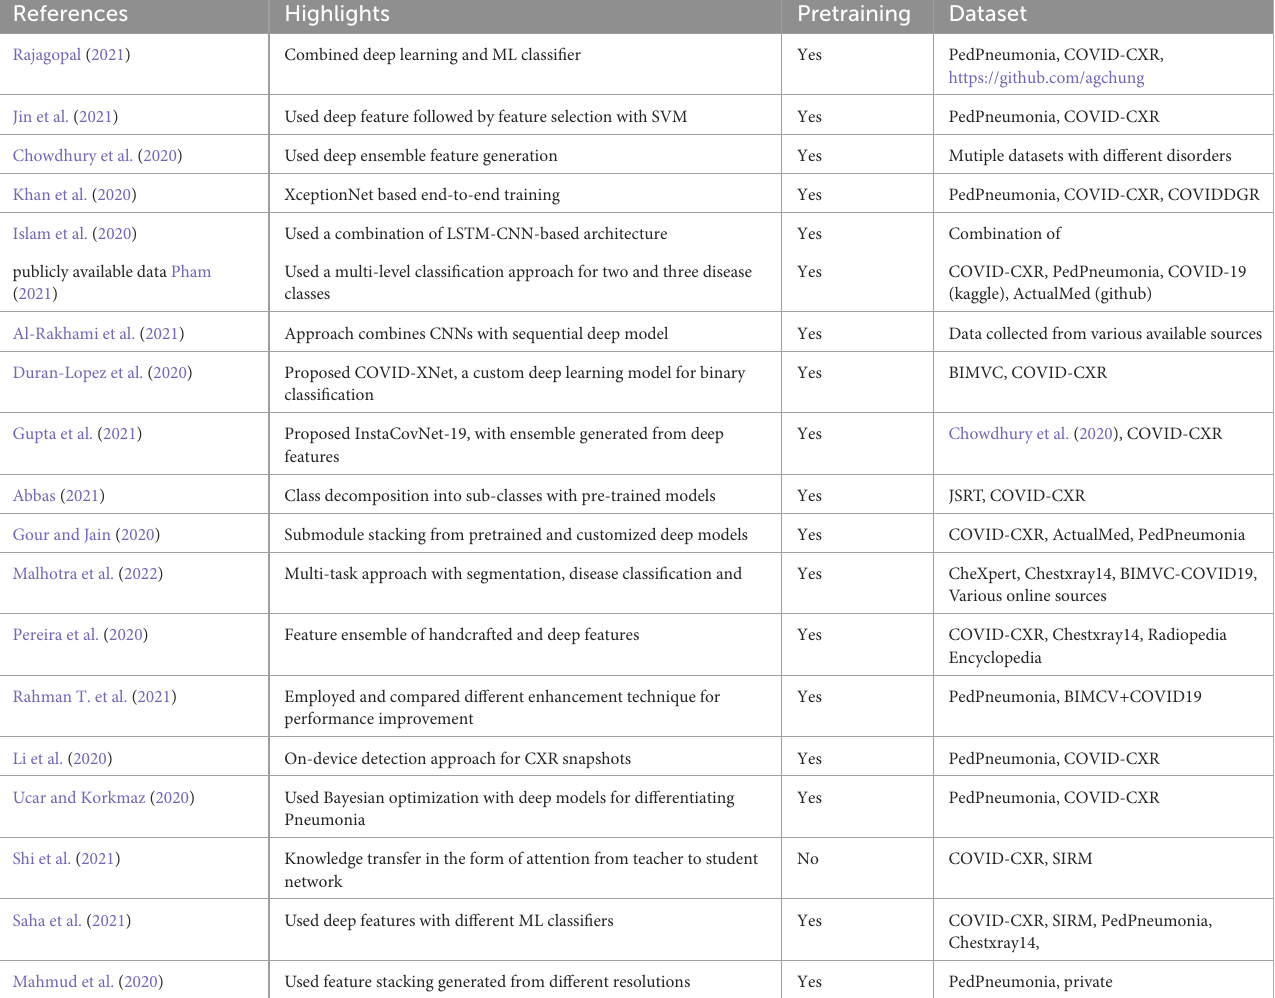
TABLE 6 Review of the literature for COVID19 detection using